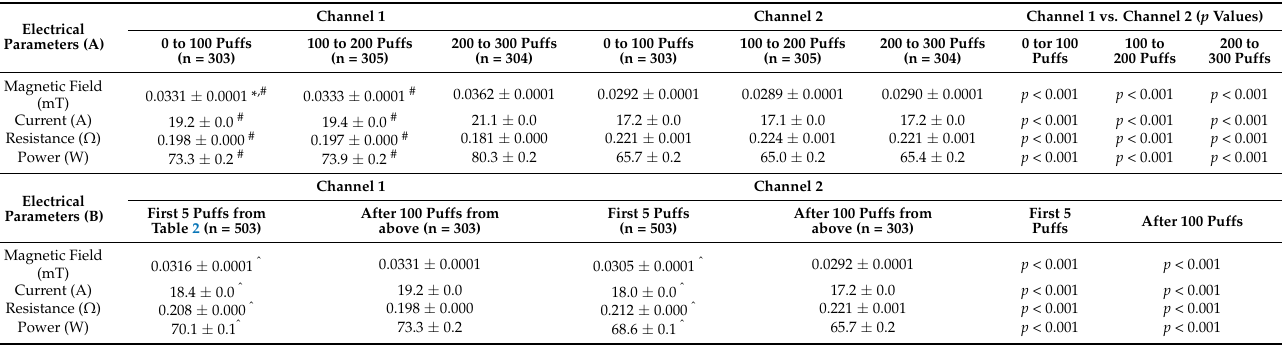
Table 3. Electrical